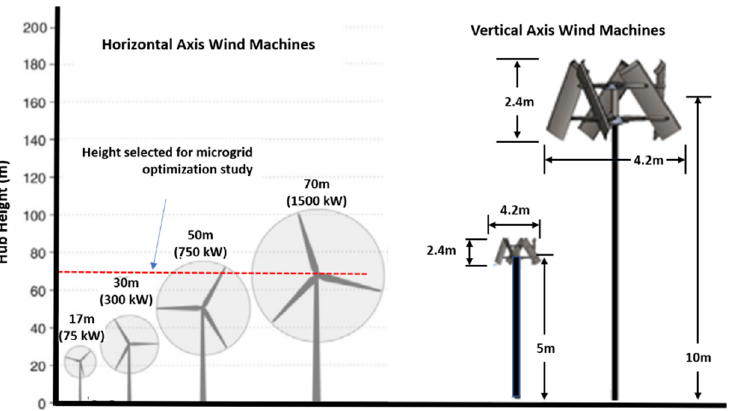
Figure 7. Various wind machine configurations showing scale and power generation.